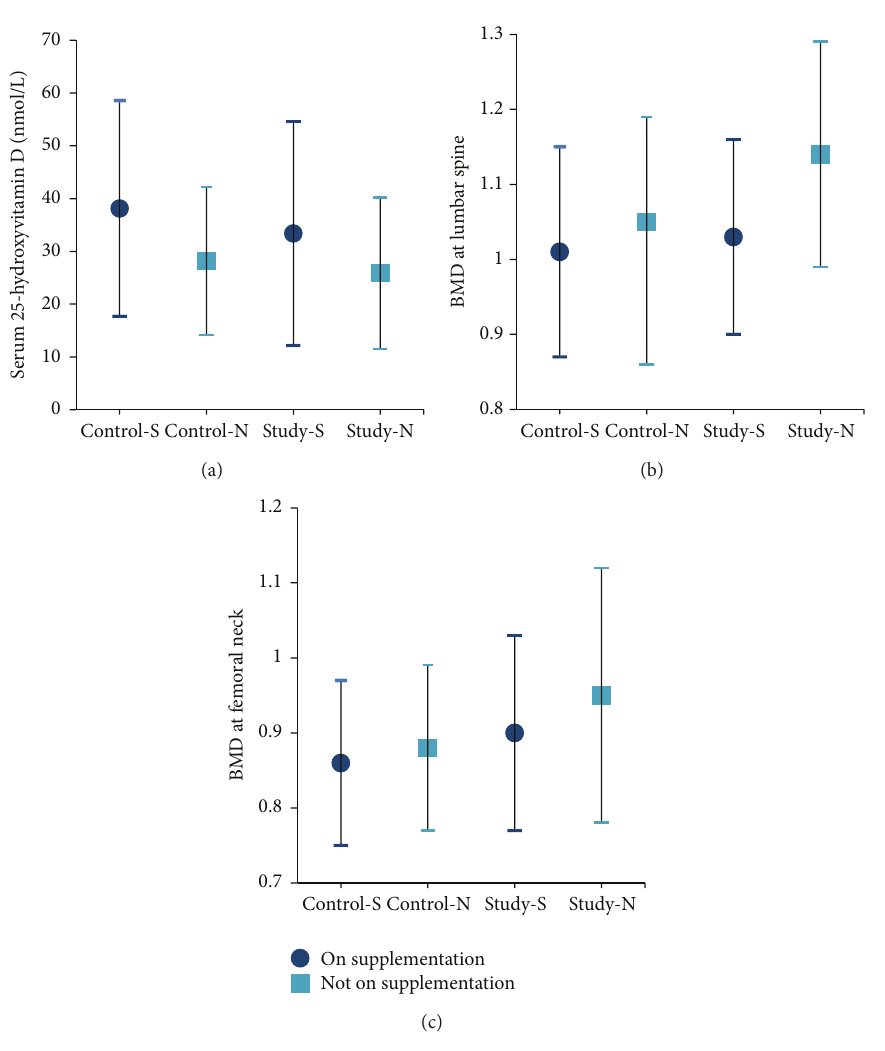
Figure 7: E ff ect of supplementation on serum 25-hydroxyvitamin D and BMD at lumbar spine and femoral neck (mean ± SD). BMD: bone mineral density; control-S: control group on supplementation; control-N: control group not on supplementation; study-S: study group on supplementation; study-N: study group not on